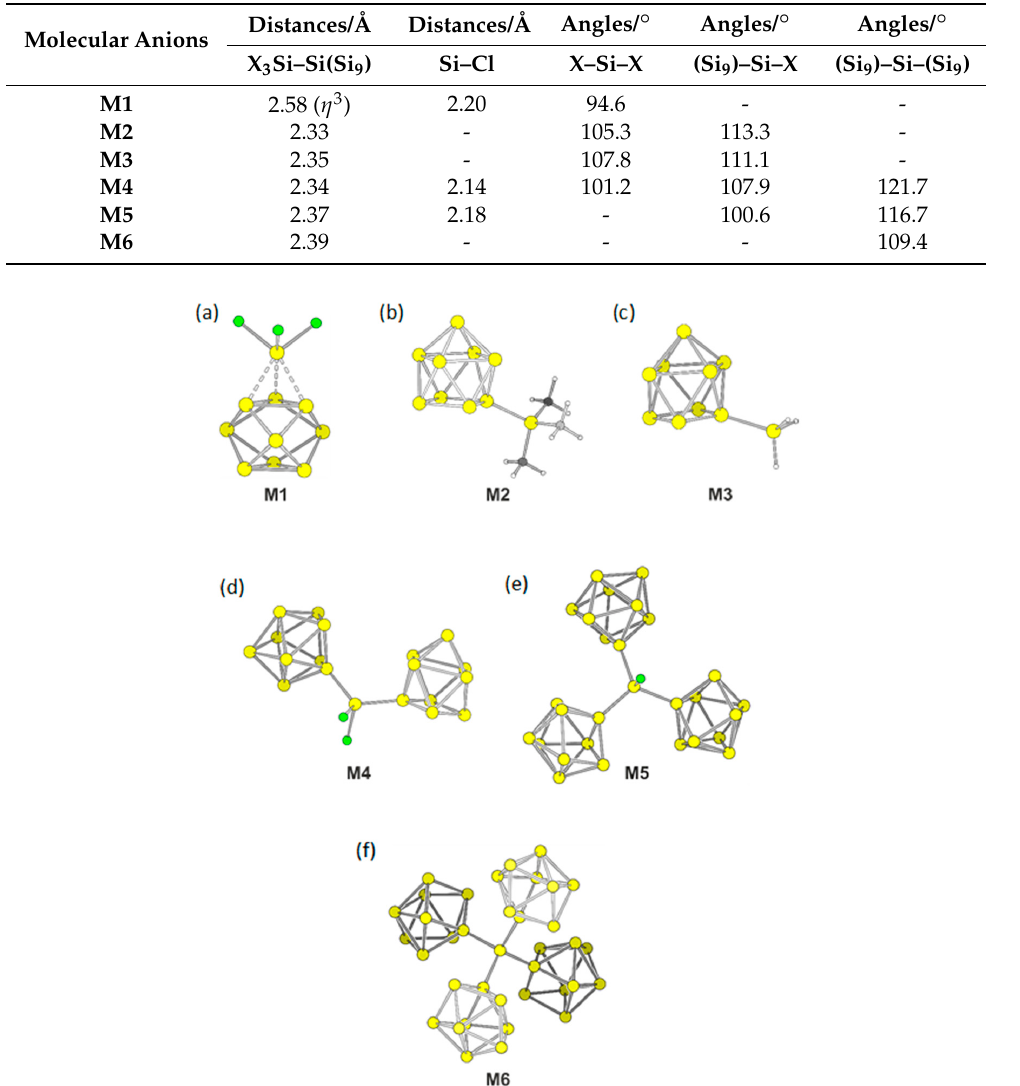
Figure 3. Optimized structures of molecular anions M1 – M6 . ( a ) η 3 -[Si(Si 9 )Cl 3 ] 3 − ( M1 ), ( b ) η 1 -[Si(Si 9 )Me 3 ] 3 − ( M2 ), ( c ) η 1 -[Si(Si 9 )H 3 ] 3 − ( M3 ), ( d ) [SiCl 2 (Si 9 ) 2 ] 6 − ( M4 ), ( e ) [SiCl(Si 9 ) 3 ] 9– ( M5 ), ( f ) [Si(Si 9 ) 4 ] 12 − ( M6 ). Si and Cl atoms are shown as yellow and green spheres, respectively.